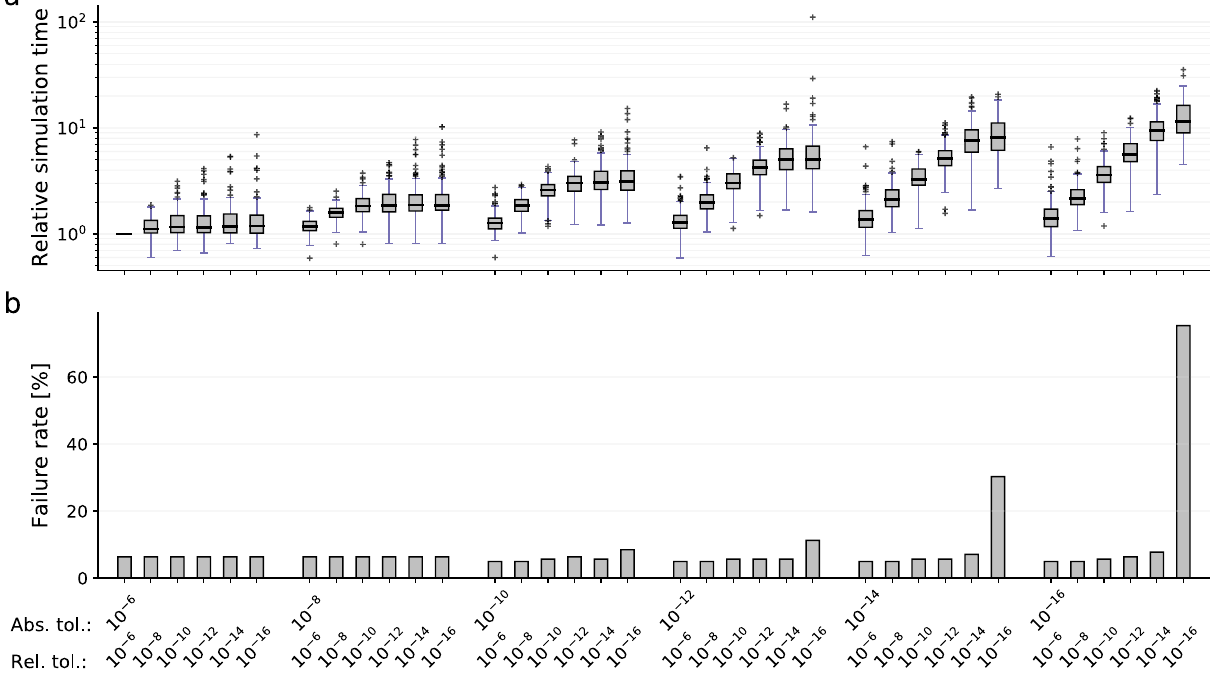
Figure 4. Integration error tolerances. Comparison of 36 combinations of absolute and relative error tolerances. All models were simulated using the BDF integration algorithm, the Newton-type non-linear solver, and the linear solver KLU, for each tolerance combination. ( a ) Relative simulation times, normalised by those for absolute and relative error tolerances ( 10 − 6 , 10 − 6 ) . ( b ) The corresponding failure